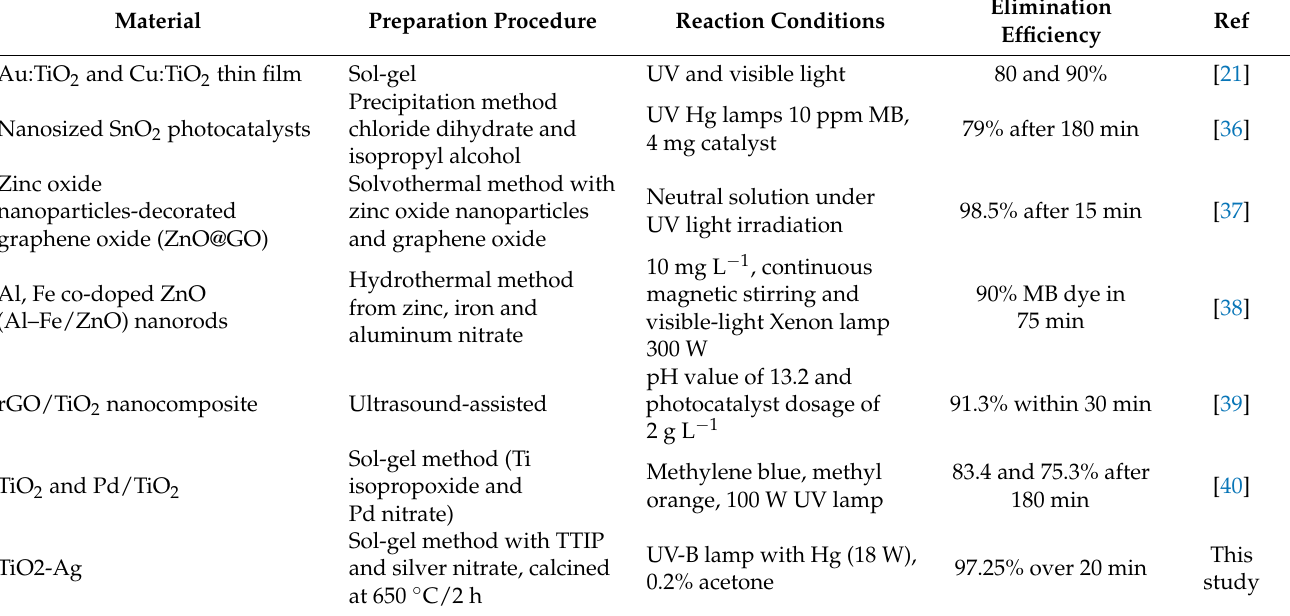
Table 2. Photocatalytic performances of different materials for MB